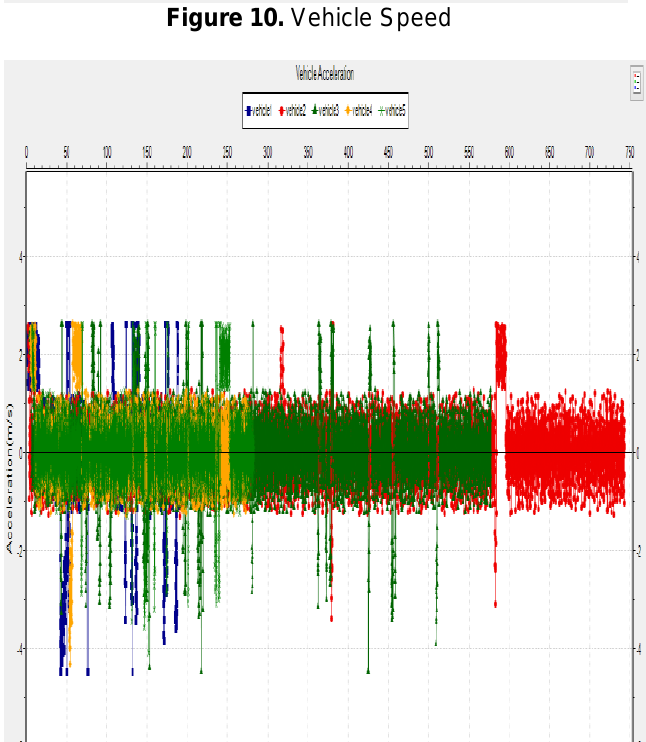
Figure 10. Vehicle Speed